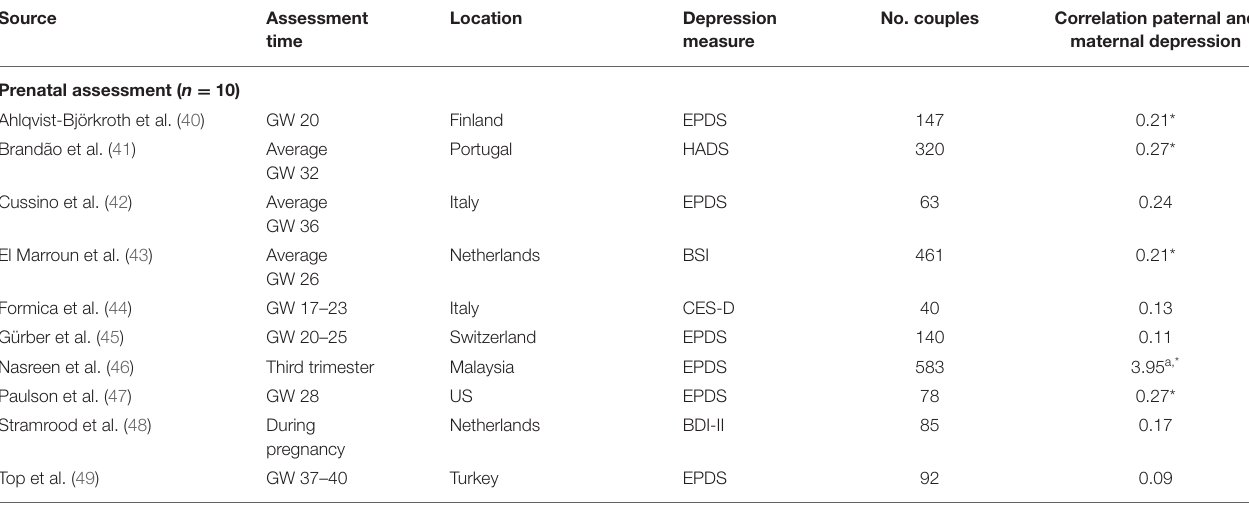
TABLE 1A | Characteristics of studies included in meta-analysis for the association between paternal and maternal depression during the prenatal